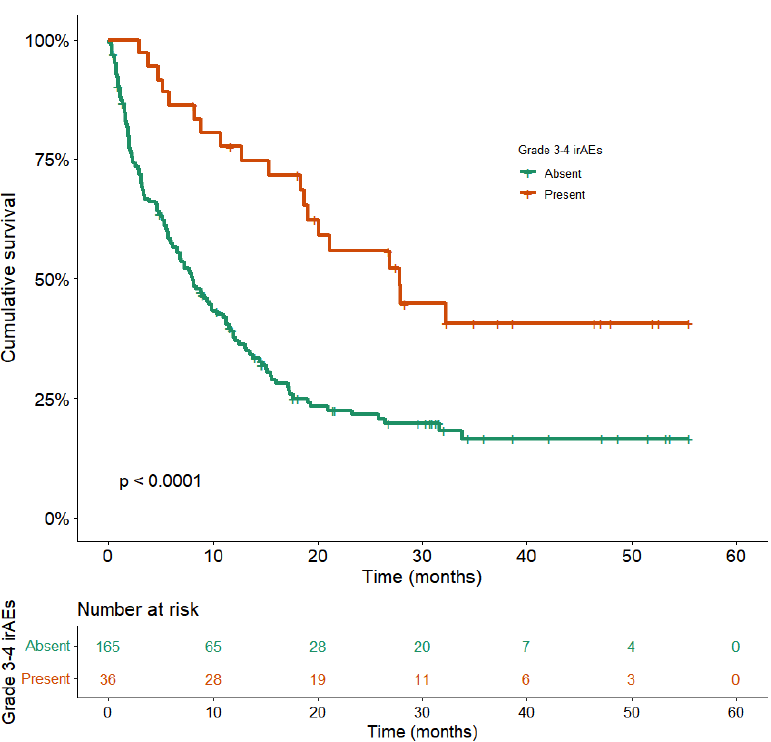
Figure 3. Overall survival according to the incidence of Grade 3 – 4 irAEs. Kaplan – Meier overall sur- vival plots according to the incidence of Grade 3 – 4 irAEs are shown. Orange OS curve: patients with survival plots according to the incidence of Grade 3–4 irAEs are shown. Orange OS curve: patients Grade 3 – 4 irAEs (n = 165), median OS: 27.8 months (95%CI: 17.0 – 38.7). Green OS curve: patients with Grade 3–4 irAEs (n = 165), median OS: 27.8 months (95%CI: 17.0–38.7). Green OS curve: patients without Grade 3 – 4 irAEs (n = 36), median OS: 8.1 (95% CI: 5.9 – 10.4). ( p < 0.0001, log-rank test). without Grade 3–4 irAEs (n = 36), median OS: 8.1 (95% CI: 5.9–10.4). ( p < 0.0001, log-rank In univariable analysis, female gender, PS ≤ 1, absence of antibiotic or corticosteroid intake, fewer than three metastatic sites, higher PD-L1 tumor expression, lower TNM stage, absence of liver or brain metastases, and lowest LIPI score were all significantly associated with a longer OS.